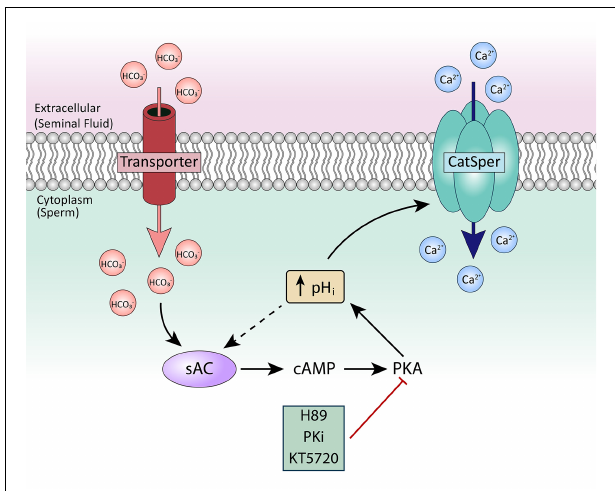
FIGURE 10 | Proposed model for CatSper activation in ejaculated human and mouse sperm. After ejaculation, sperm are exposed to HCO 3 − in the seminal fluid. HCO 3 − activates sAC, leading to production of cAMP, which activates PKA. PKA stimulates alkalinization of the cytoplasm, which sensitizes CatSper to respond to membrane